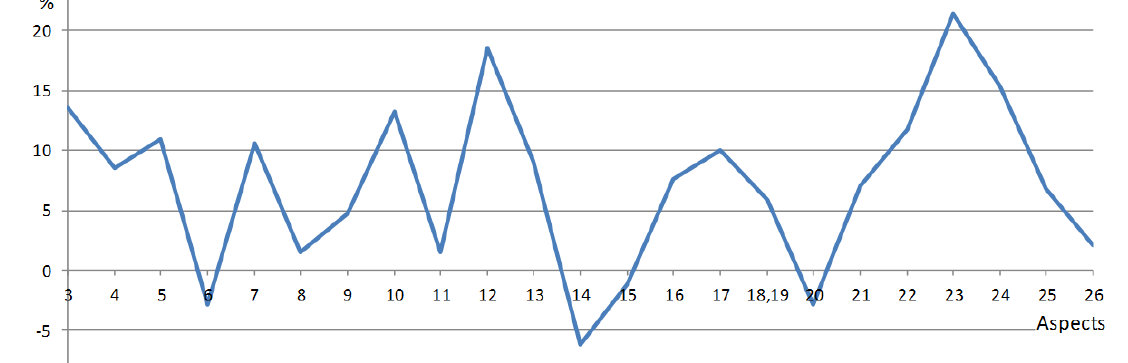
Figure 2. Difference %ICT-EOls - %non - ICT-EOls dependence on aspects 3 – 26 at 100% i- security performance.